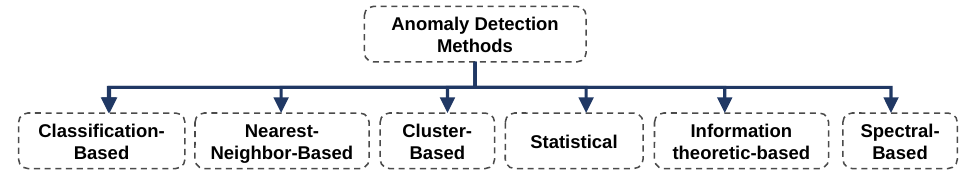
Figure 5. Taxonomy of AD methods